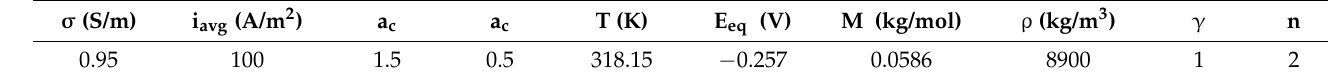
Table 1. Simulation